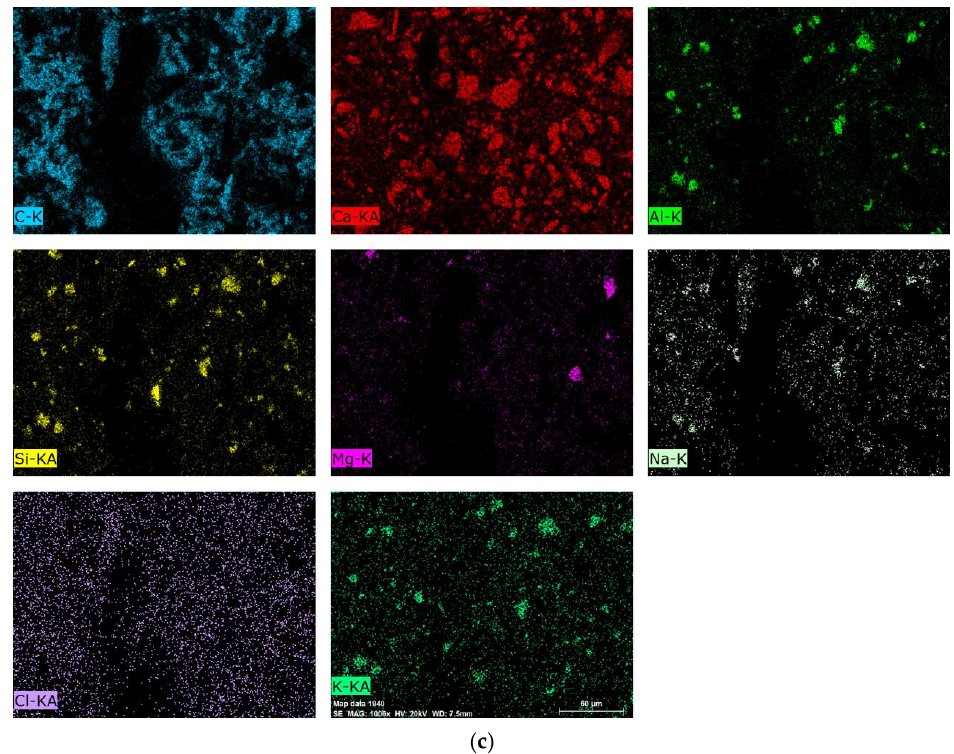
Figure 9. ( a ) SEM image of the unaged polymer (I), magnification 1000×, ( b ) analysis of the EDS elemental composition of the surface, ( c ) mapping of the elements present in the sample.